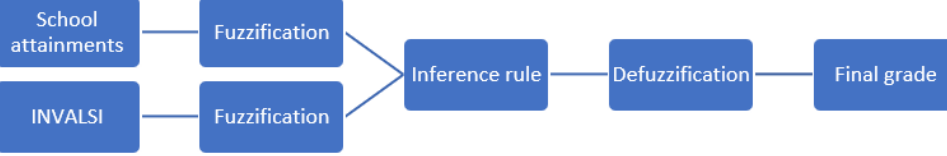
Figure 3. The utilized model for the assessment of students’ mathematical knowledge.